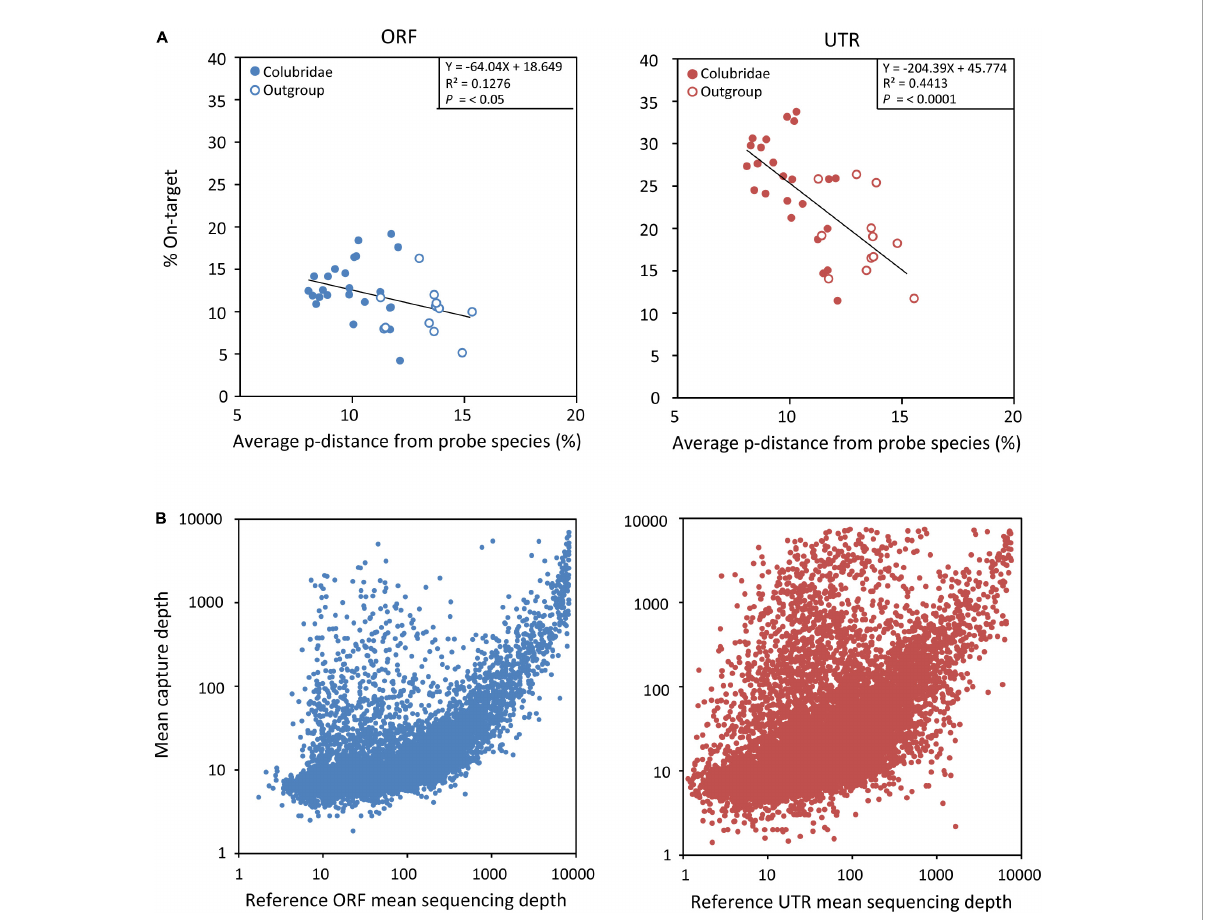
FIGURE4 (A) Plots of linear regressions of capture specificity (on-target) across all samples in FLc-Capture experiments (blue = ORF, red = UTR), using the average pairwise distance from probe species as the independent variable. (B) Relationship between the mean capture depth of each target and the abundance of its corresponding probe (blue = ORF, red =